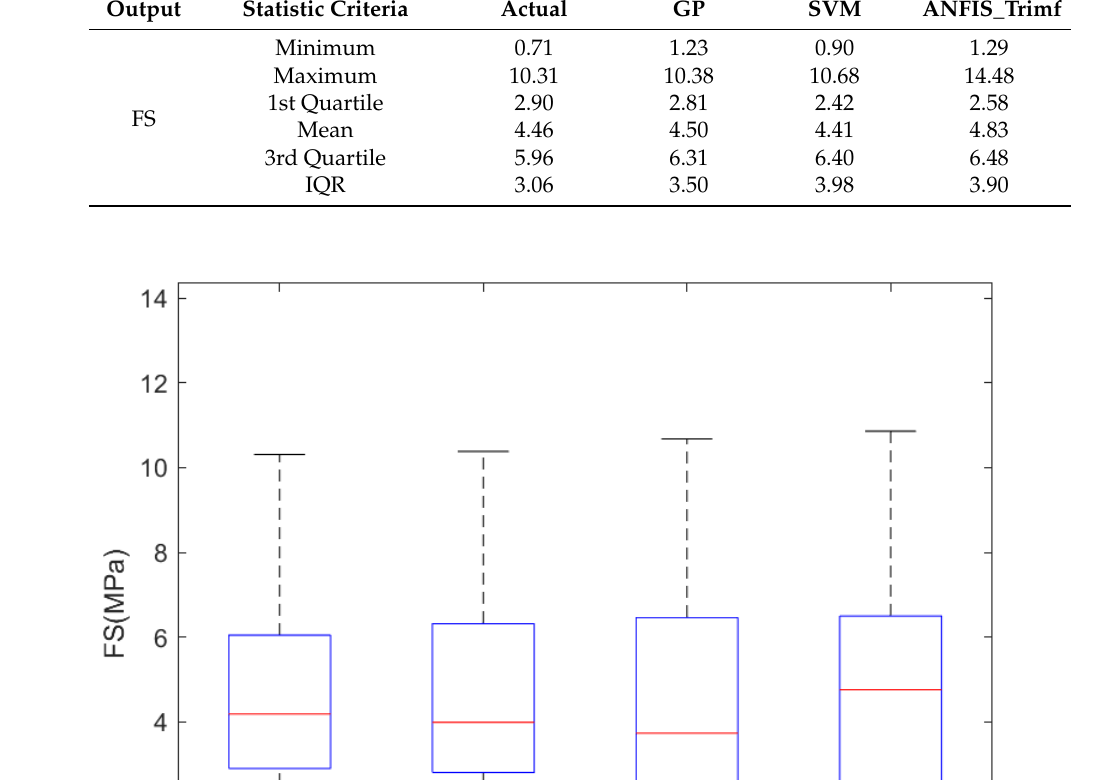
Table 11. Performances of SVM, GP, and ANFIS for FS < 10 MPa and FS > 10